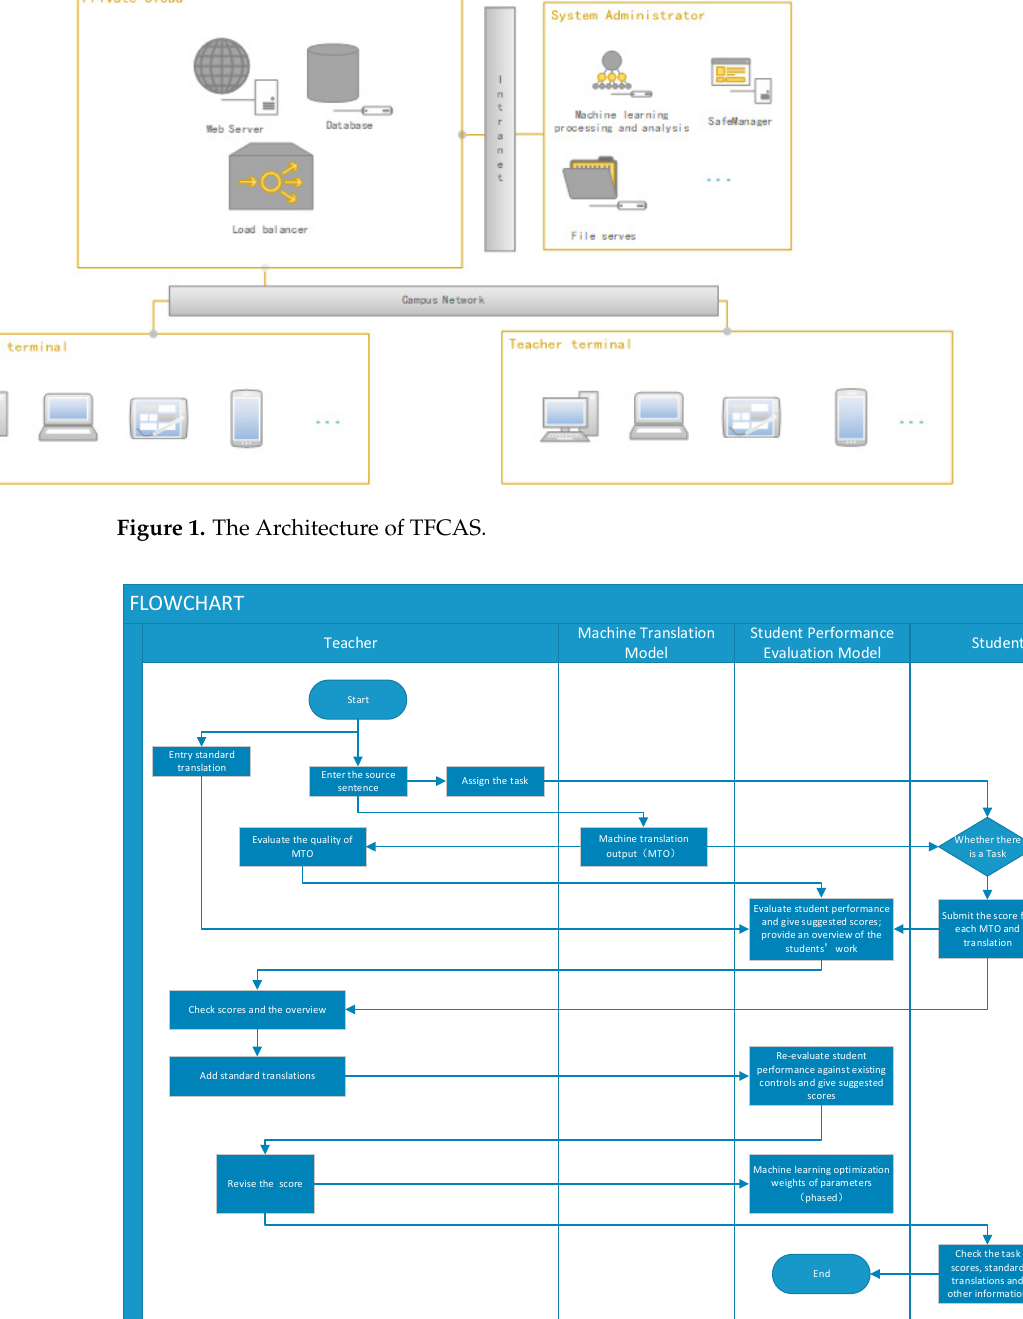
Figure 2. The workflow of TFCAS.